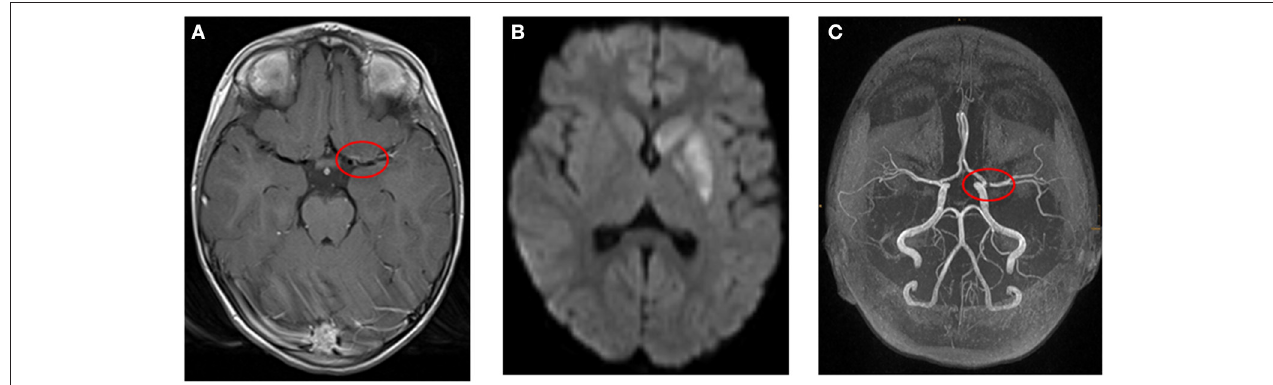
FIGURE 2 | (A–C) Example for a 4-year-old girl with ischemic stroke due to large vessel vasculitis and right-sided hemiparesis and facial palsy. (A) Transversal T1-weighted MR image after contrast shows wall enhancement of the middle cerebral artery (red circle). (B) Transversal diffusion-weighted image (b1000) shows restricted diffusion in the left basal ganglia. (C) Time-of-flight MR angiography demonstrates stenosis of the middle cerebral artery (red circle, left).